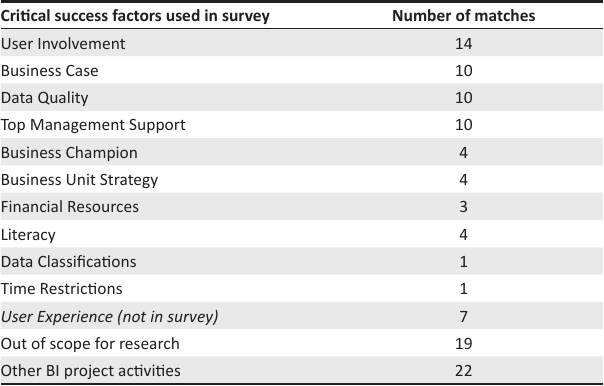
TABLE 3: Participants’ free text feedback on what they considered their top five critical success factors ( N =